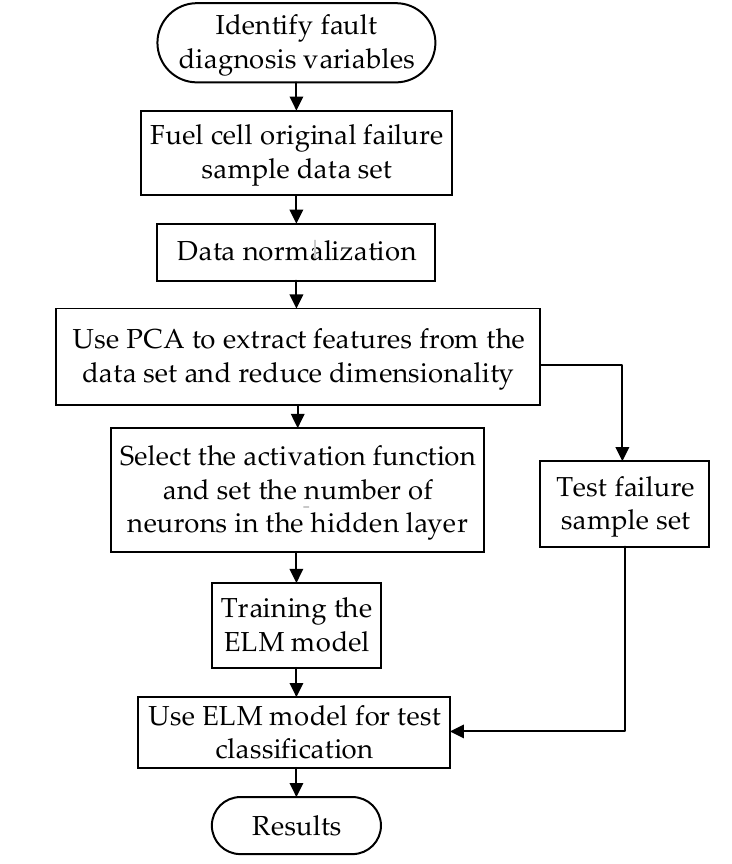
Figure 4. Flow diagram of ELM diagnosis process.